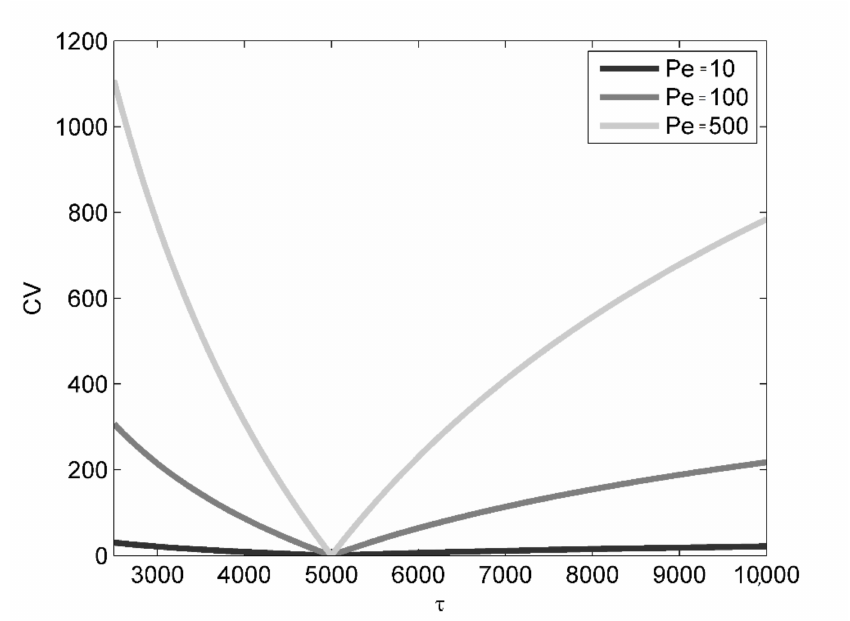
= 0.1. CV is the concentration Y